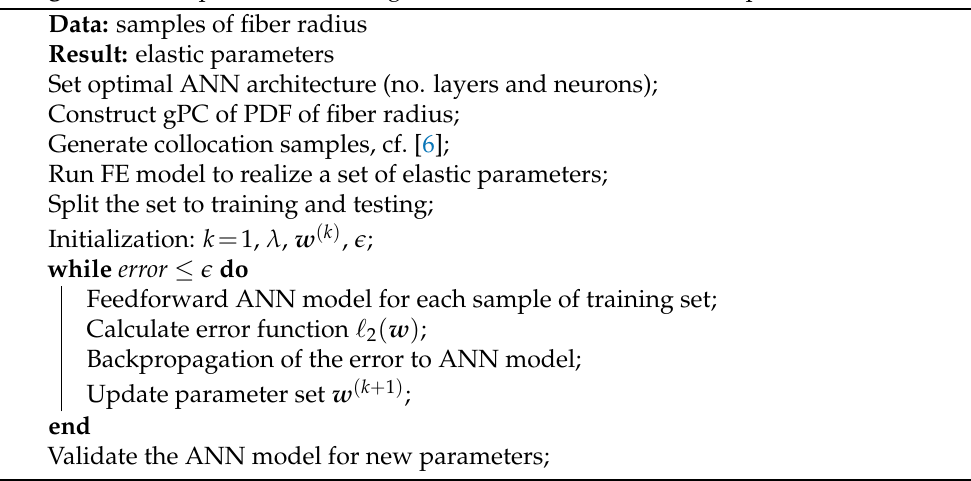
Algorithm 1: Supervised ANN algorithm for estimation of elastic